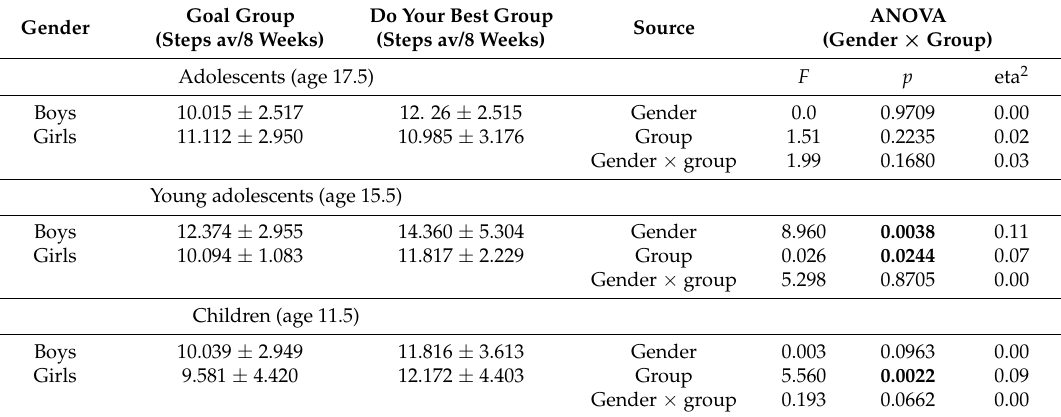
Table 2. Means, standard deviations and differences in daily steps across age